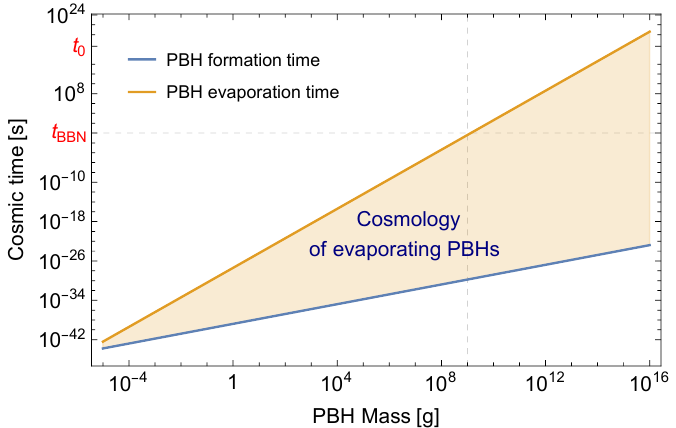
Figure 2. The mass range and timescales of evaporating PBH cosmology. The lifetime of the universe and the cosmic time of BBN are highlighted. The former subdivides the evaporating PBHs from the dark matter PBHs; the latter defines a threshold upper mass scale, M PBH ∼ 10 9 g, where PBHs evaporation does not upset the hot big bang